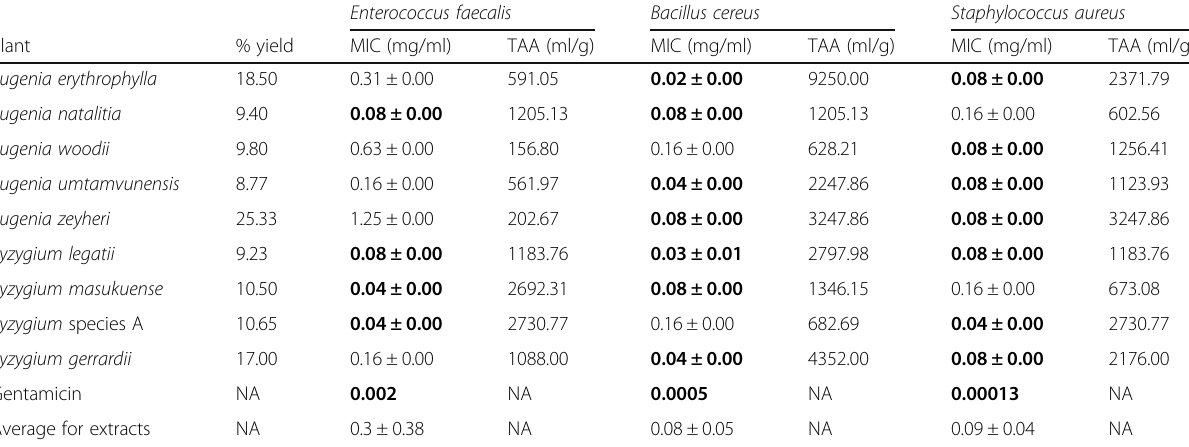
Table 1 Yield of extract, minimum inhibitory concentration (MIC) and total antibacterial activity (TAA) of the nine selected acetone leaf extracts against Gram-positive test bacteria. Values equal to or less than 0.1 mg/ml indicate high